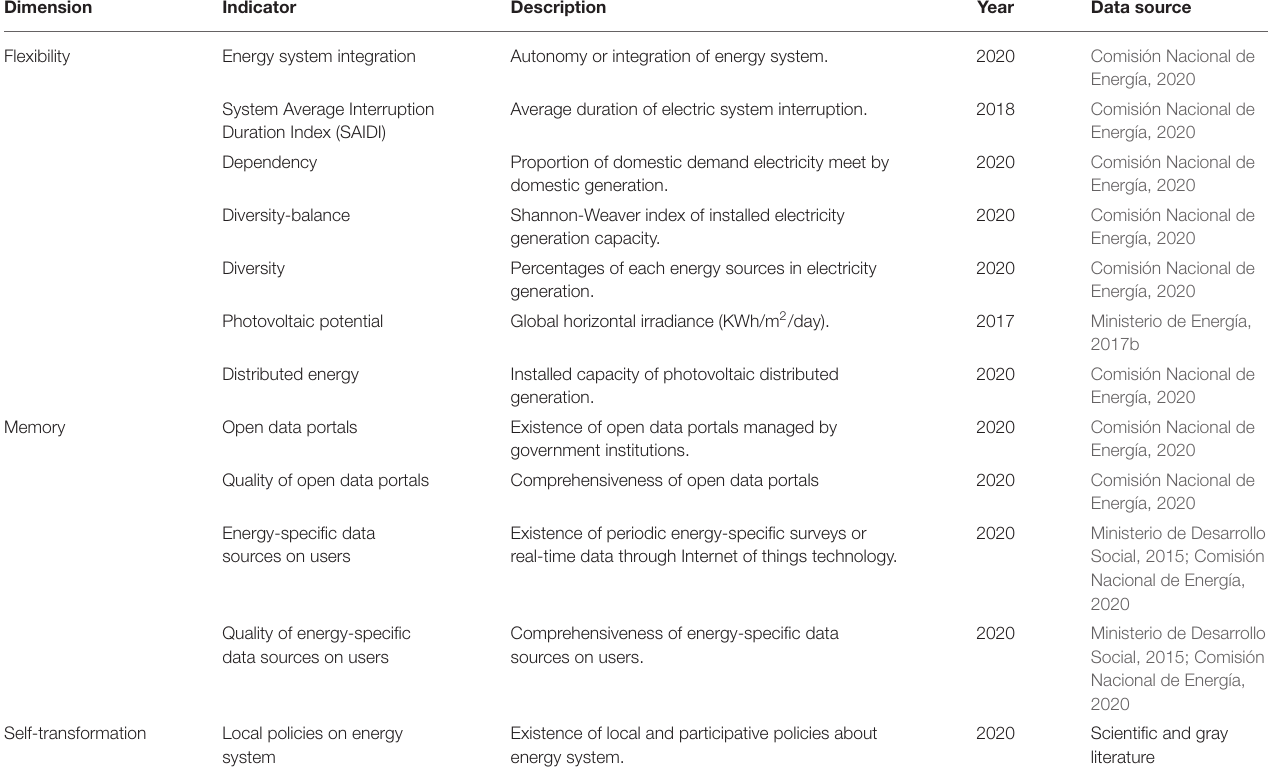
TABLE 3 | Resilience